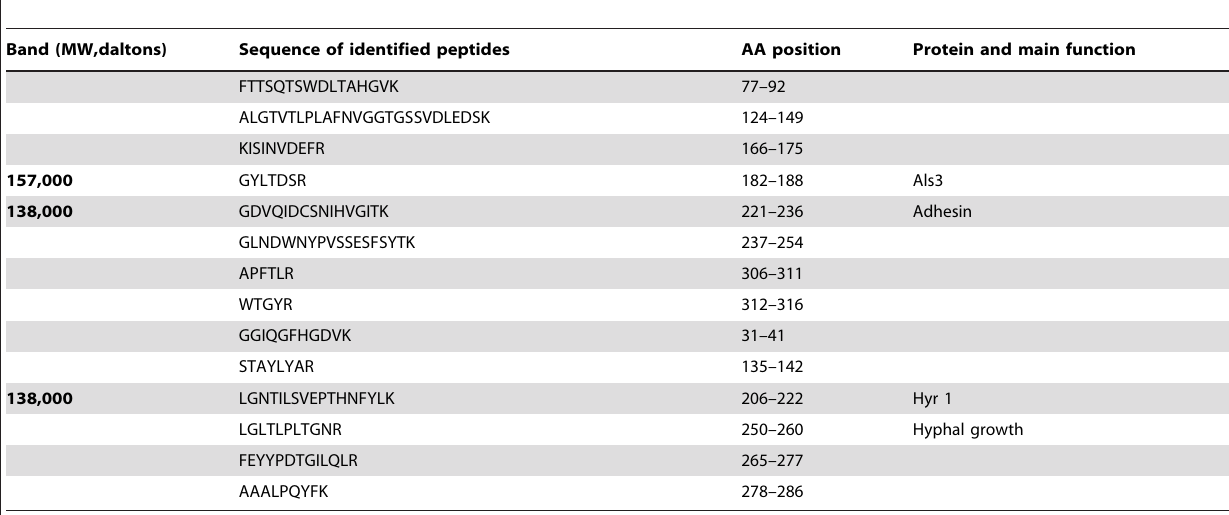
Table 2. Identification of Als3 and Hyr1 proteins in fungal secretion.